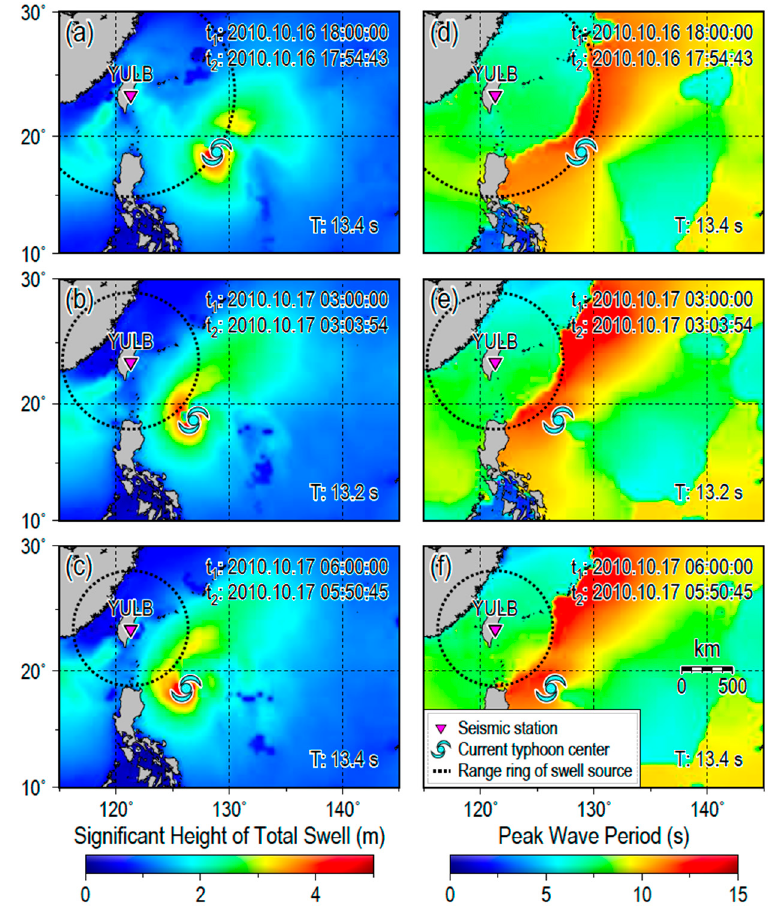
Figure 6. Typhoon-induced swell propagation calculated from dispersive DF microseisms at station YULB, compared with ( a – c ) significant heights of total swells and ( d – f ) peak wave periods at time t 1 as predicted by ERA5 reanalysis. The dotted circle centered on station YULB, with radius equal to the propagation distance x , represents the probable location of the origin of each swell. The origin time and initial wave period of the typhoon-induced swell are denoted t 2 and T , respectively, and the hurricane symbols indicate the locations of the typhoon center.